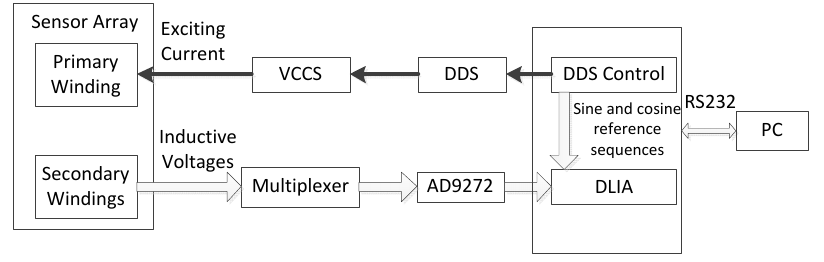
Figure 7. Schematic diagram of the measurement system.